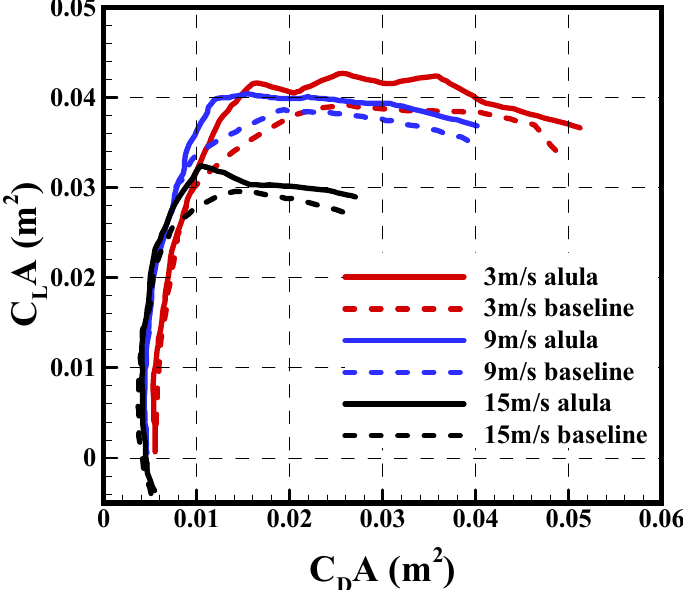
Figure 4. Polar curve based on the lift area and the drag area of specimen at different velocities (different colors represent different freestream velocities; solid line: with the alula; dotted line: without the alula) [6].